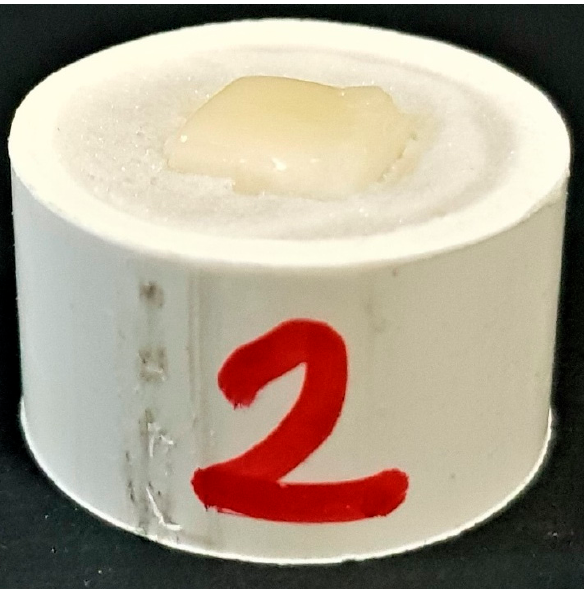
Figure 1. Zirconia specimen layered with ceramic and embedded in a resin block. Table 1. Details of the materials used in this